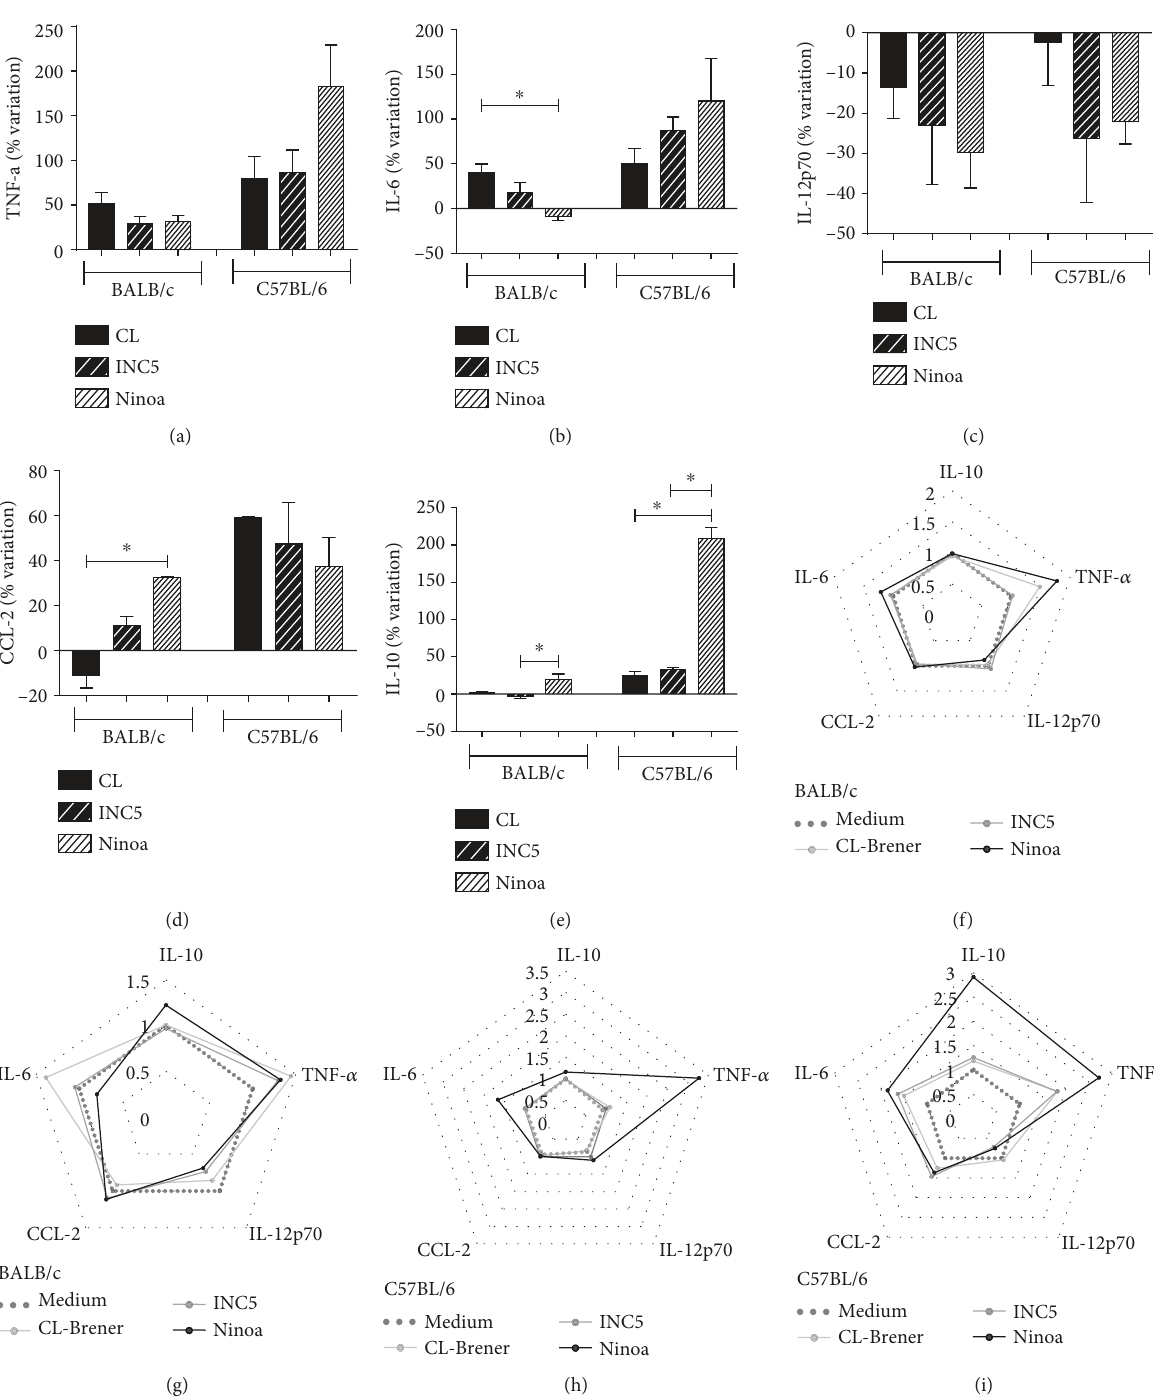
Figure 4: Percentage of variation in the levels of pro-and anti-in fl ammatory cytokines and CCL-2 chemokine in the supernatant of BMDCs of BALB/c and C57BL/6 mice. The variation of cytokines was calculated by determination of percentage of increment or reduction in cytokines produced by T. cruzi- infected BMDCs previously stimulated with LPS and those maintained only with LPS (5 μ g/mL). (f, h) Representation of the radar graph of the cytokine pattern in the dendritic cell culture supernatant. The lines highlight the change in cytokine levels in dendritic cells infected with di ff erent strains (MOI 2:1) in relation to the medium only with dendritic cells. (g, i) The pattern of cytokines in the dendritic cell culture supernatant previously stimulated with LPS. Data were obtained by calculating the ratio between T. cruzi -infected cells and their respective control. Statistical analysis, when applicable, was performed with the Kruskal-Wallis test with Dunn ’ s posttest, where ∗ , ∗∗ p < 0 05